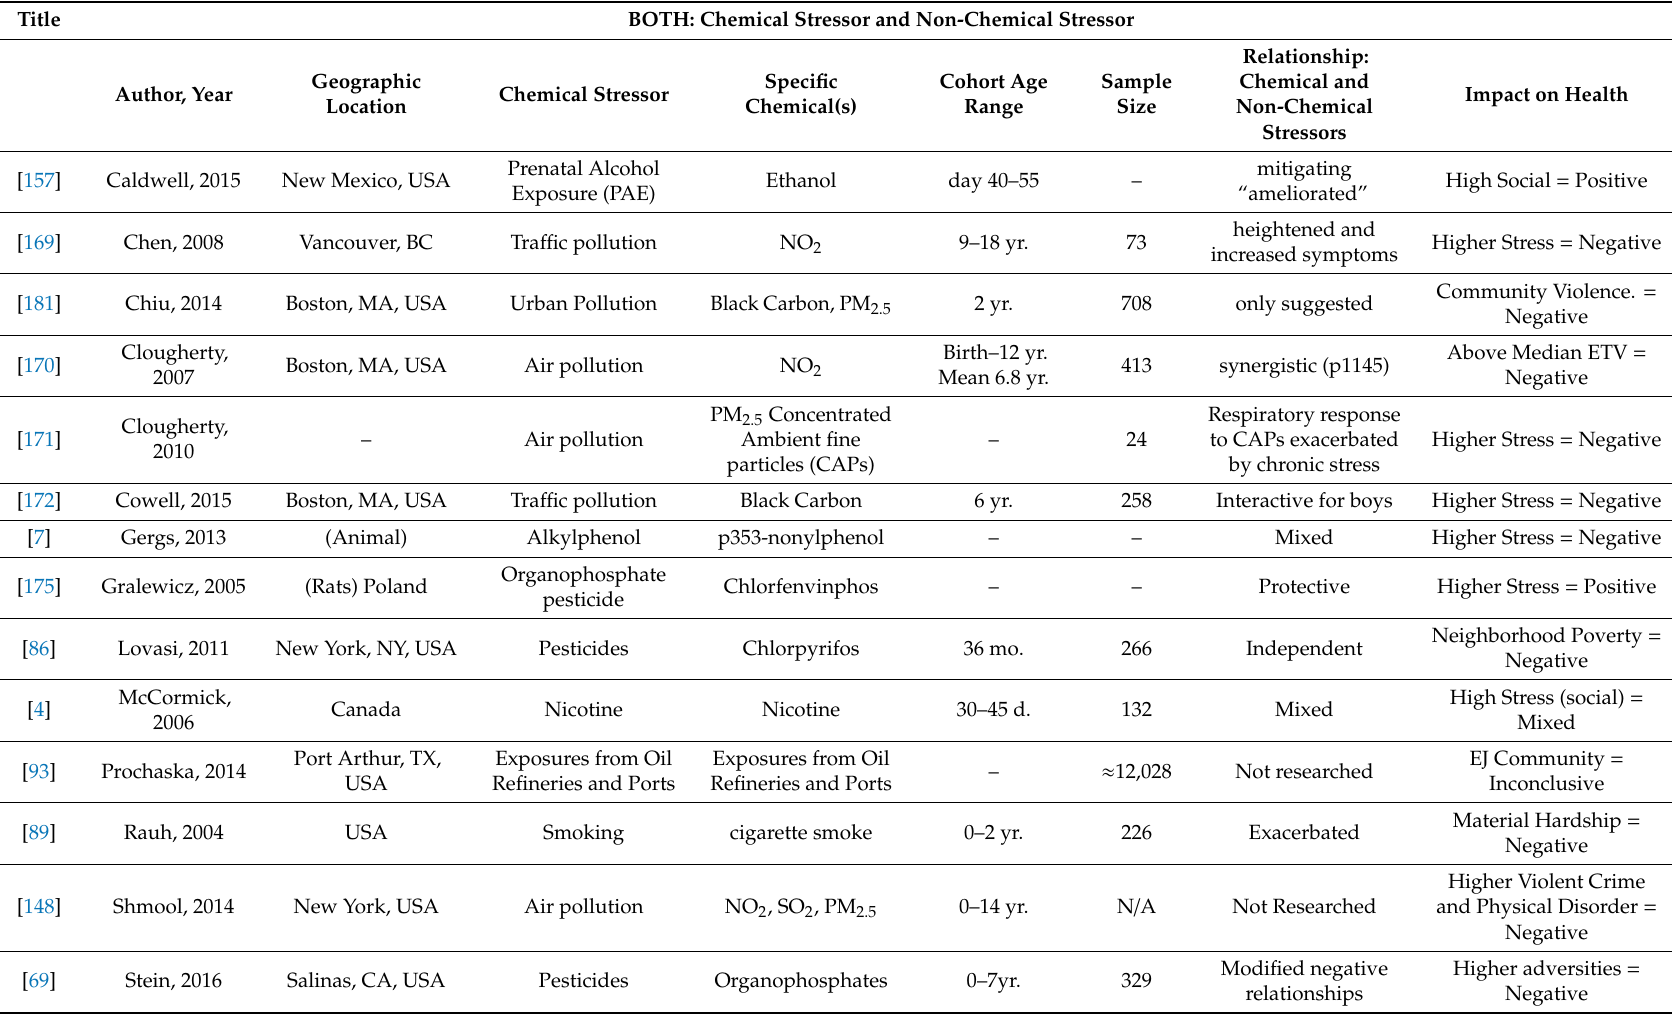
Table 2. Summary of the studies included in review that researched both chemical and non-chemical